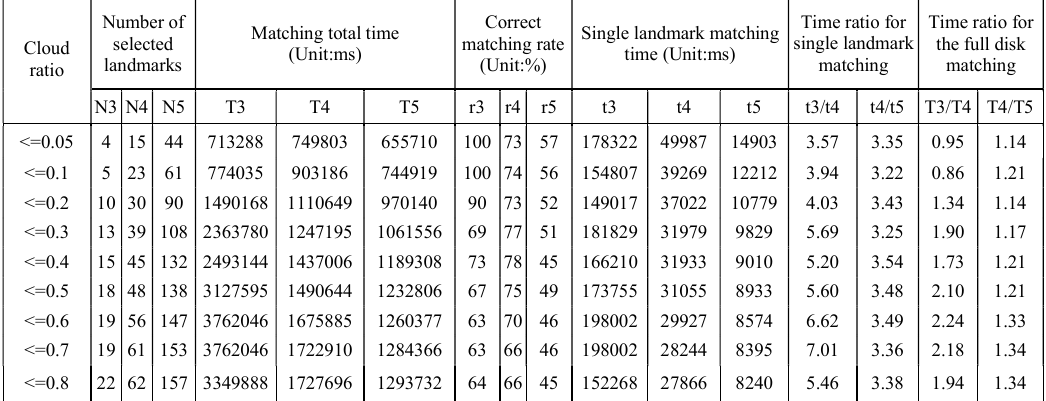
Table 1. Parameter of landmarks matching under different cloud